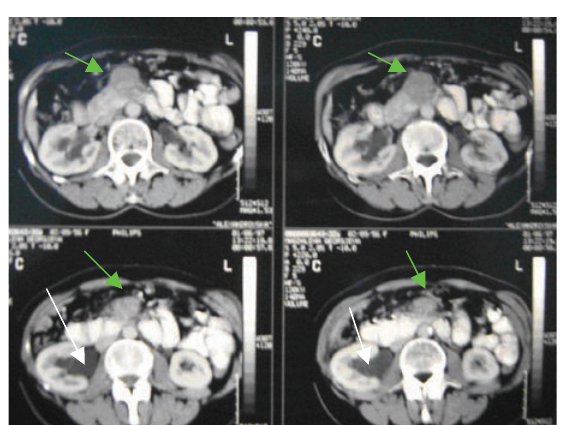
Figure 3. Abdominal CT showing a peripancreatic mass (green arrows) and dilation of the right renal pelvis (white